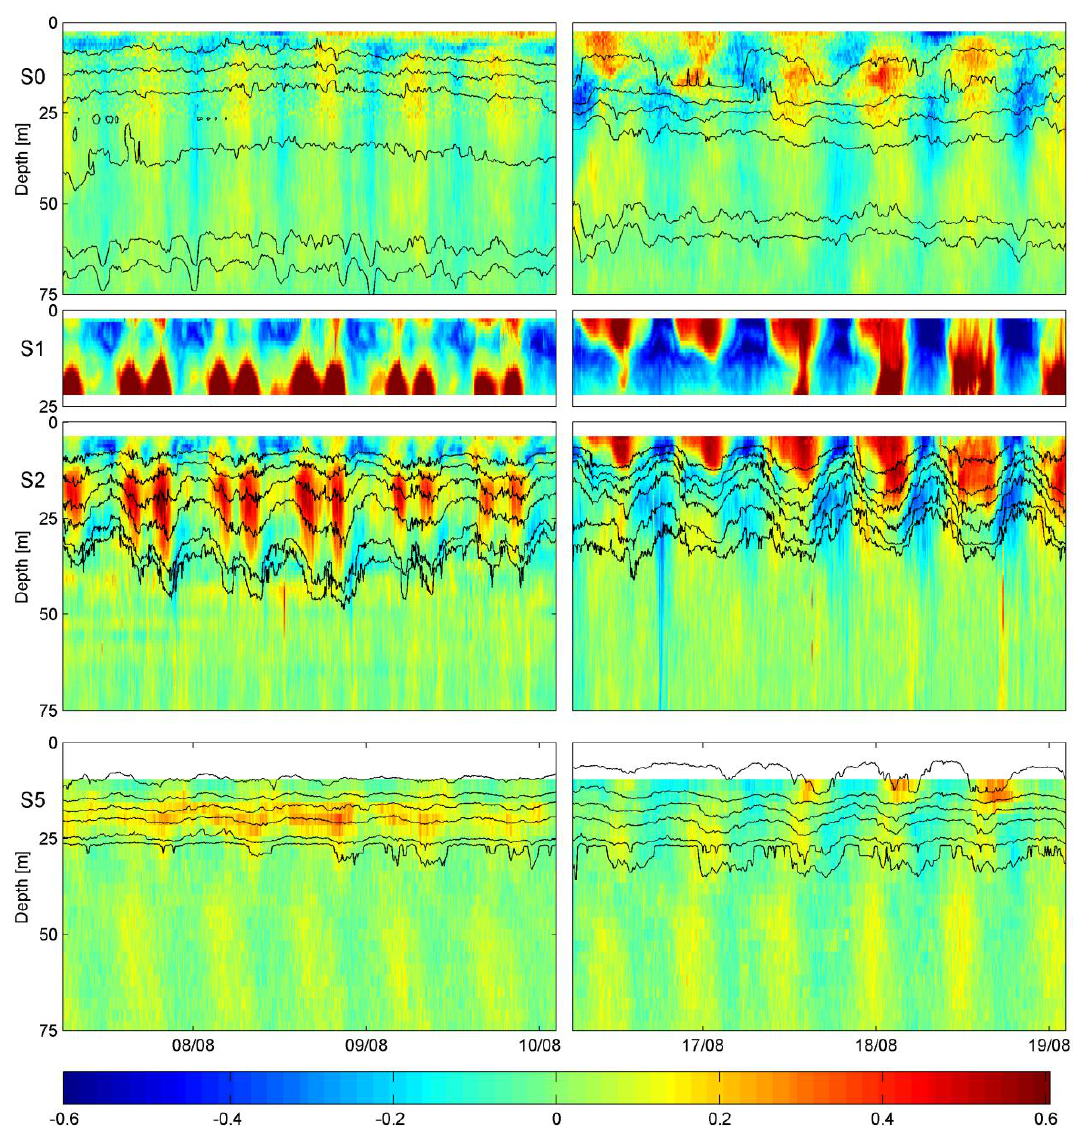
Figure 5. The current speed along the fjord measured with acoustic current profilers at station S0 (Brenntangen), S1 (Drøbak sill), S2 (Kahol- men) and S5 (Søndre Lang˚ara) is shown with a colour scale where red indicates current into and blue current out of the fjord. Temperatures of 8.5, 9, 11, 13, 15 and 17 ◦ C increasing upwards are shown by black contour lines at stations S0, S2 and S5. The temperature has been interpolated linearly between the depths of the moored instruments. Two periods are shown: from 7 to 10 August when the sea surface amplitude was about 11cm and from 16 to 19 August when the amplitude was 21cm.